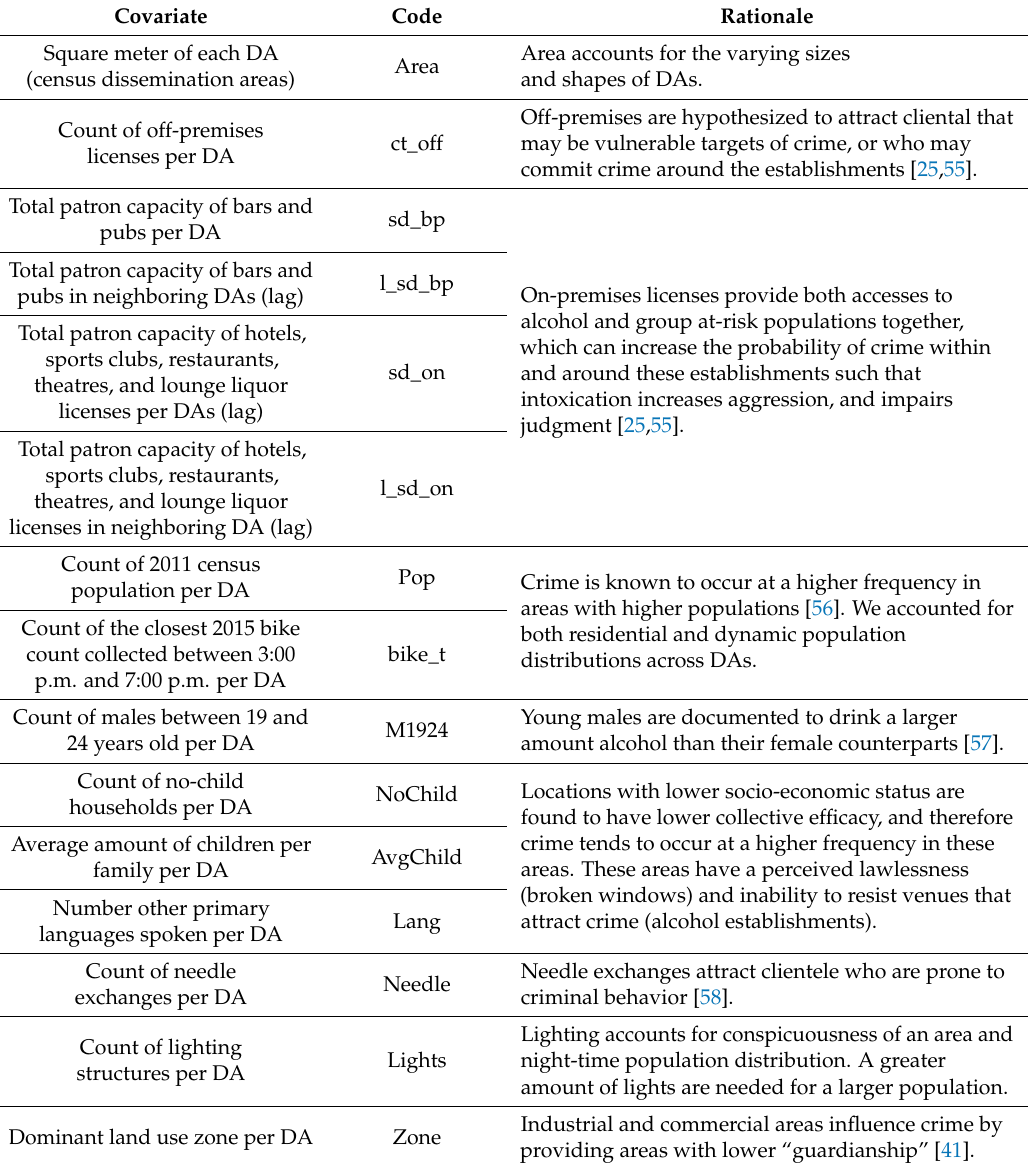
Table 1. Summary of covariates used to model and predict violent and disorder crimes across the 138 dissemination